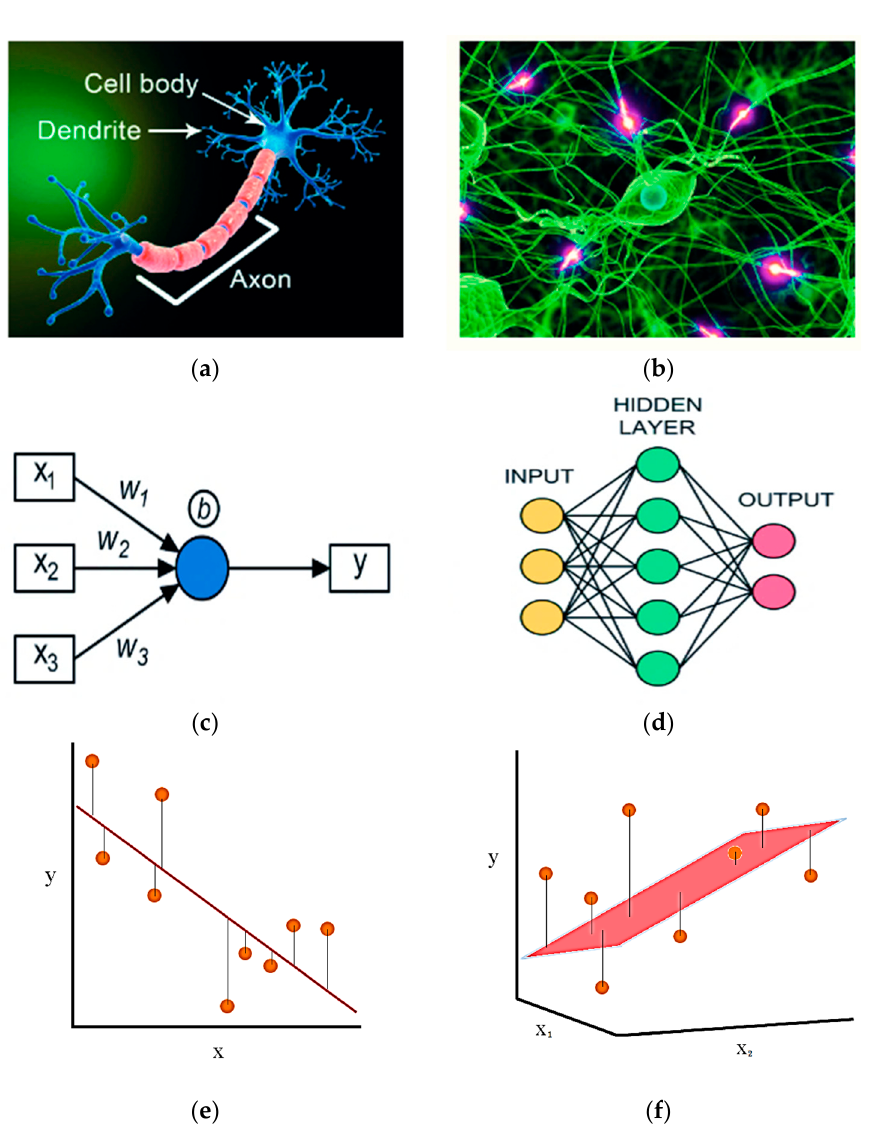
Figure 13. ( a ) Biological neuron, ( b ) biological neuron network, ( c ) artificial neuron, ( d ) artificial neural network, ( e ) simple linear regression, ( f ) multiple linear regression.